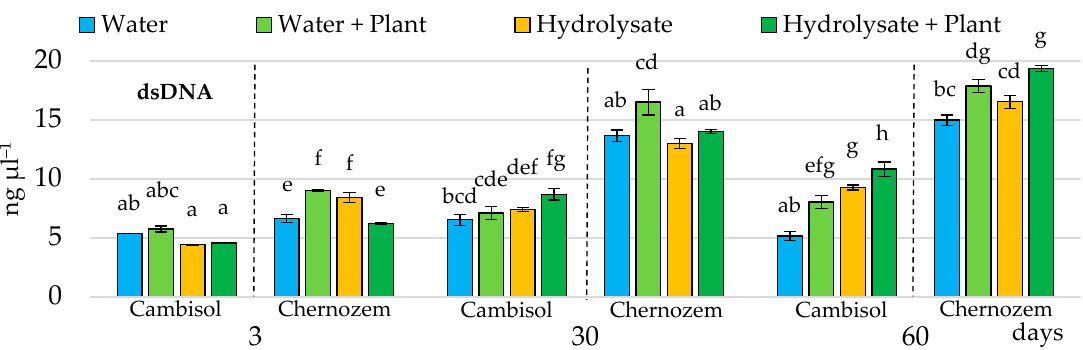
Figure 3. Dynamics of changes in nucleic acid (dsDNA) concentration in different experimental variants; letters, i.e., a, b, c, d denote the means that form homogenous groups (HSD–Tukey post hoc test for multivariate ANOVA). When two compared means were assigned the same letter (e.g., a, a or ab, ab) that means did not differ significantly (at α = 0.05); if means are marked with different letters (e.g., a and b, etc.) they differ significantly from each other (at α = 0.05).